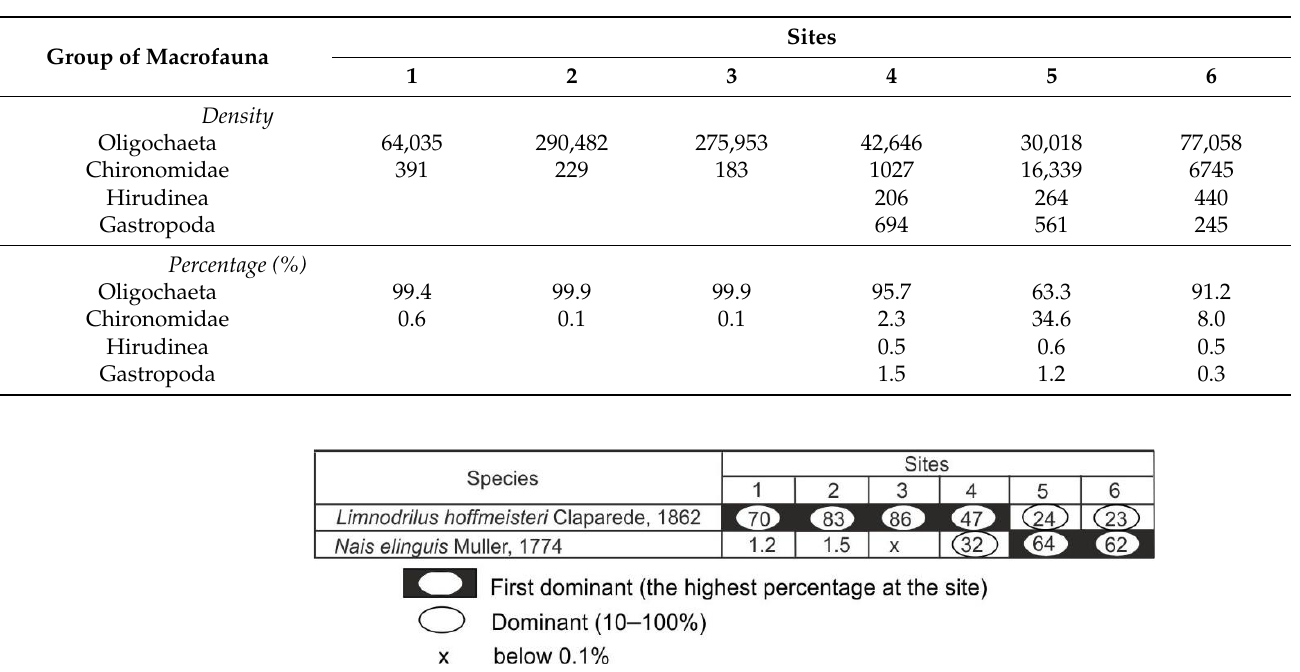
Table 3. Density (individual/m 2 ) of benthic macroinvertebrate groups and their percentage in the Vistula River in 1982 – 1983 (according to [27]).